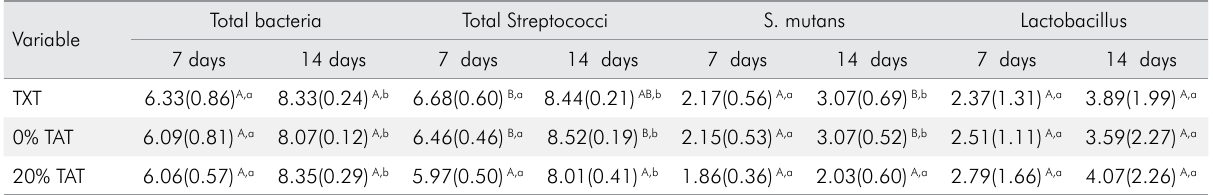
Table 2. Mean and SD of microhardness (depth and distance, in µm) of different groups after 7 and 14 days of bacterial accumulation. Total bacteria Total Streptococci S. Variable